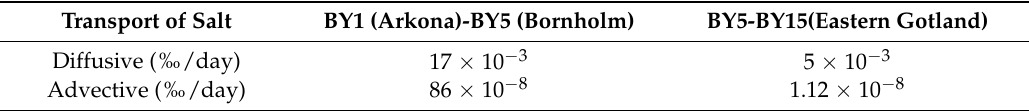
Table 5. Estimates of salinity transport in the southern basins.